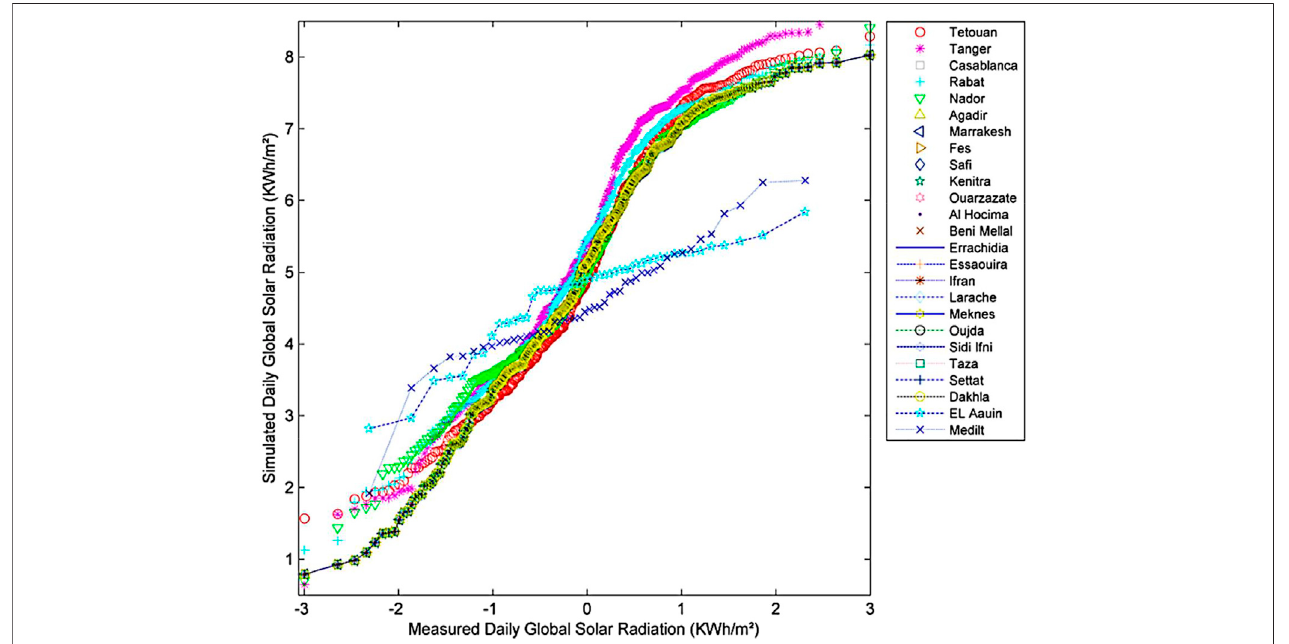
FIGURE 5 | Q-Q plot of measured and simulated daily global solar radiation generated by FFNN-BP model for 25 Moroccan locations.